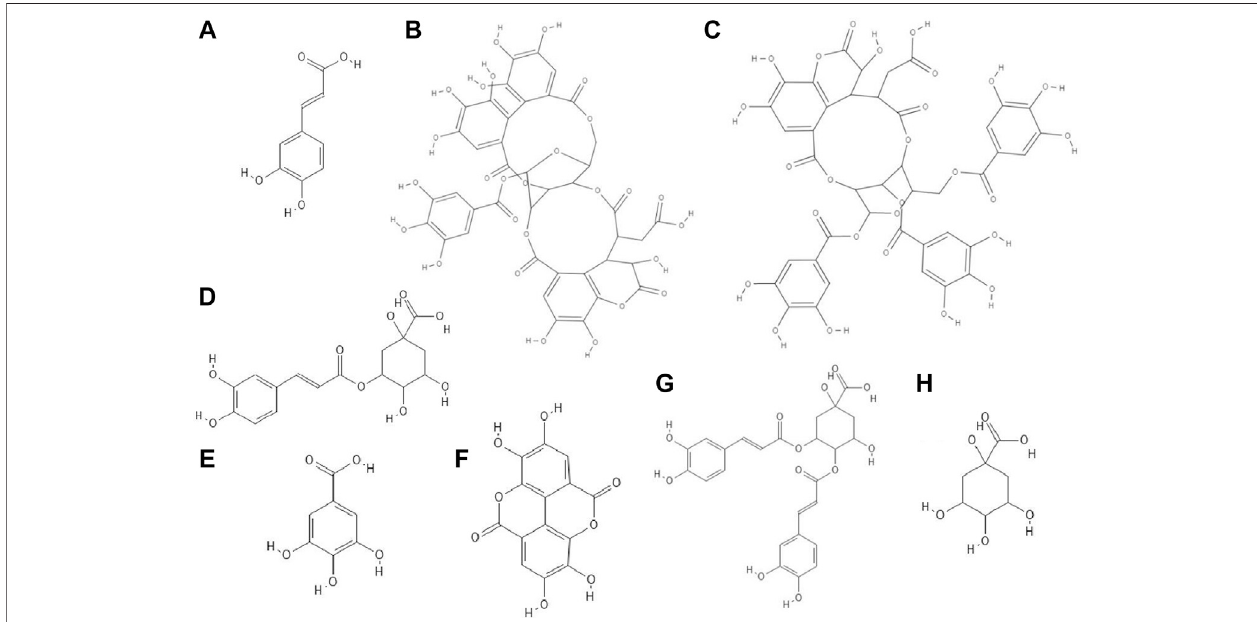
FIGURE1| Thestructuresof:caffeicacid (A) ,chebulagicacid (B) ,chebulinicacid (C) ,chlorogenicacid (D) ,gallicacid (E) ,ellagicacid (F) ,3,4-dicaffeoylquinicacid (G) , quinic acid (H) .